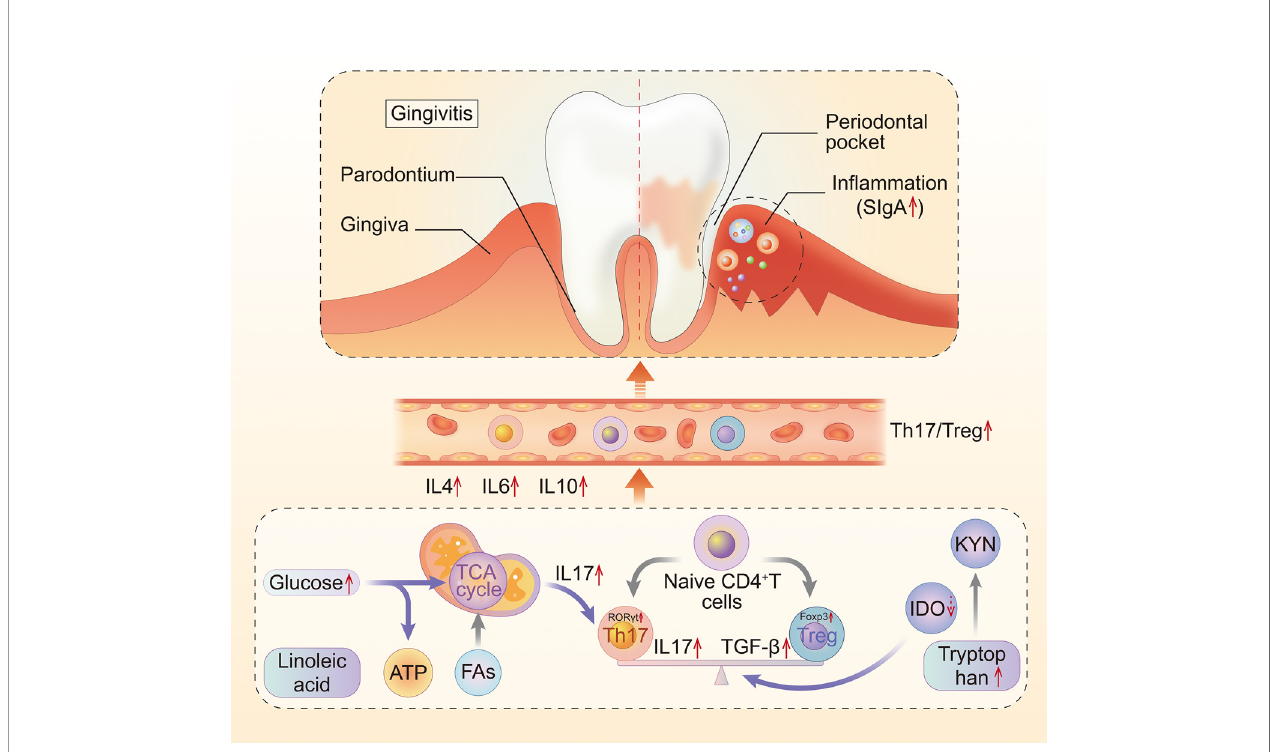
FIGURE 11 | The mechanism of the metabolic disturbance and Th17/Treg imbalance in gingivitis. Th17, T helper cell 17; Treg, regulatory T cell; Fas, fatty acid metabolism; IDO, indoleamine-pyrrole 2,3-dioxygenase; KYN,